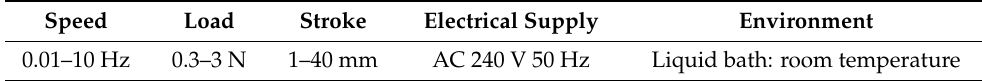
Figure 6. Fully enclosed testing machine: ( a ) CAD model and ( b ) manufactured machine. Table 1. Technical details of the test equipment .